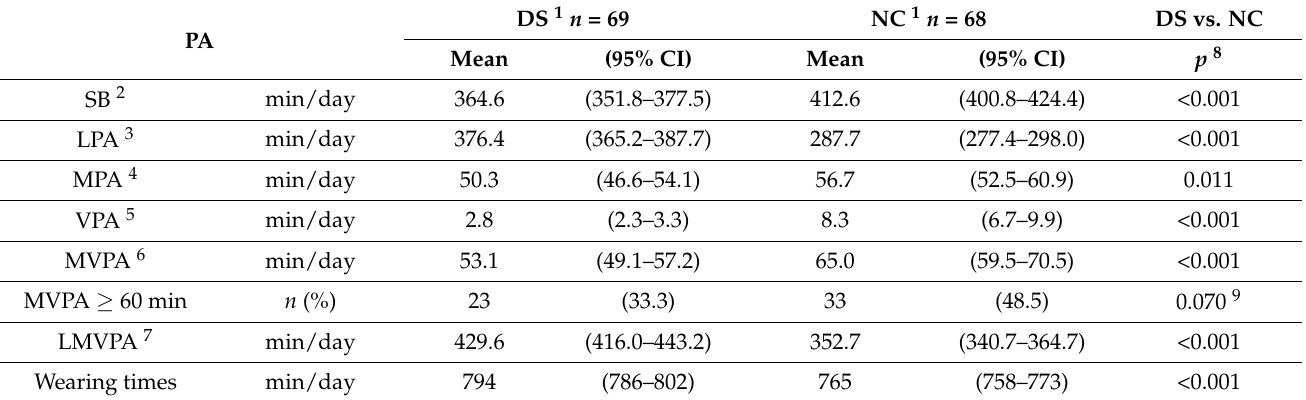
Table 2. Physical activity time for children with Down syndrome and normal children.